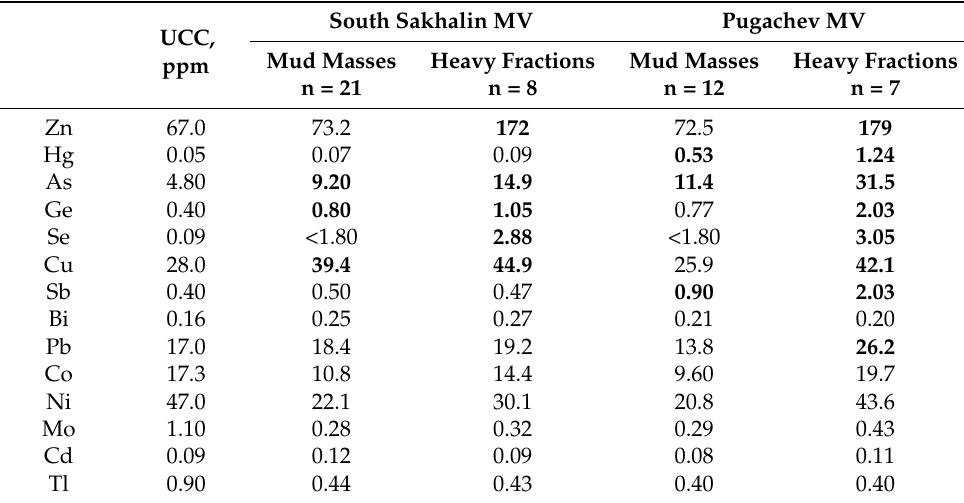
Table 3. Average trace-element compositions (ICP MS data, ppm) of mud and heavy fractions